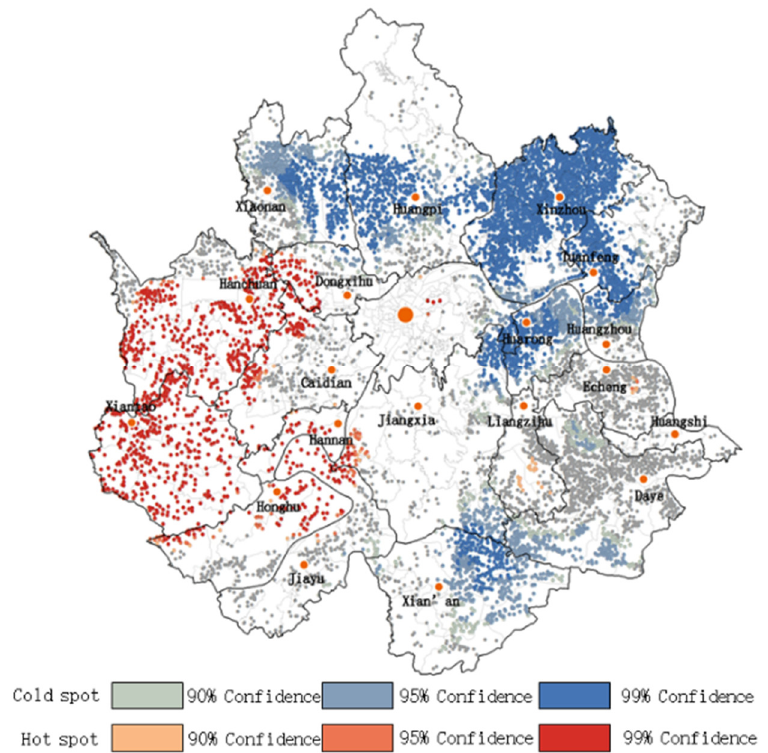
Figure 5. Analysis of the scale of rural settlements in the Wuhan metropolitan area.